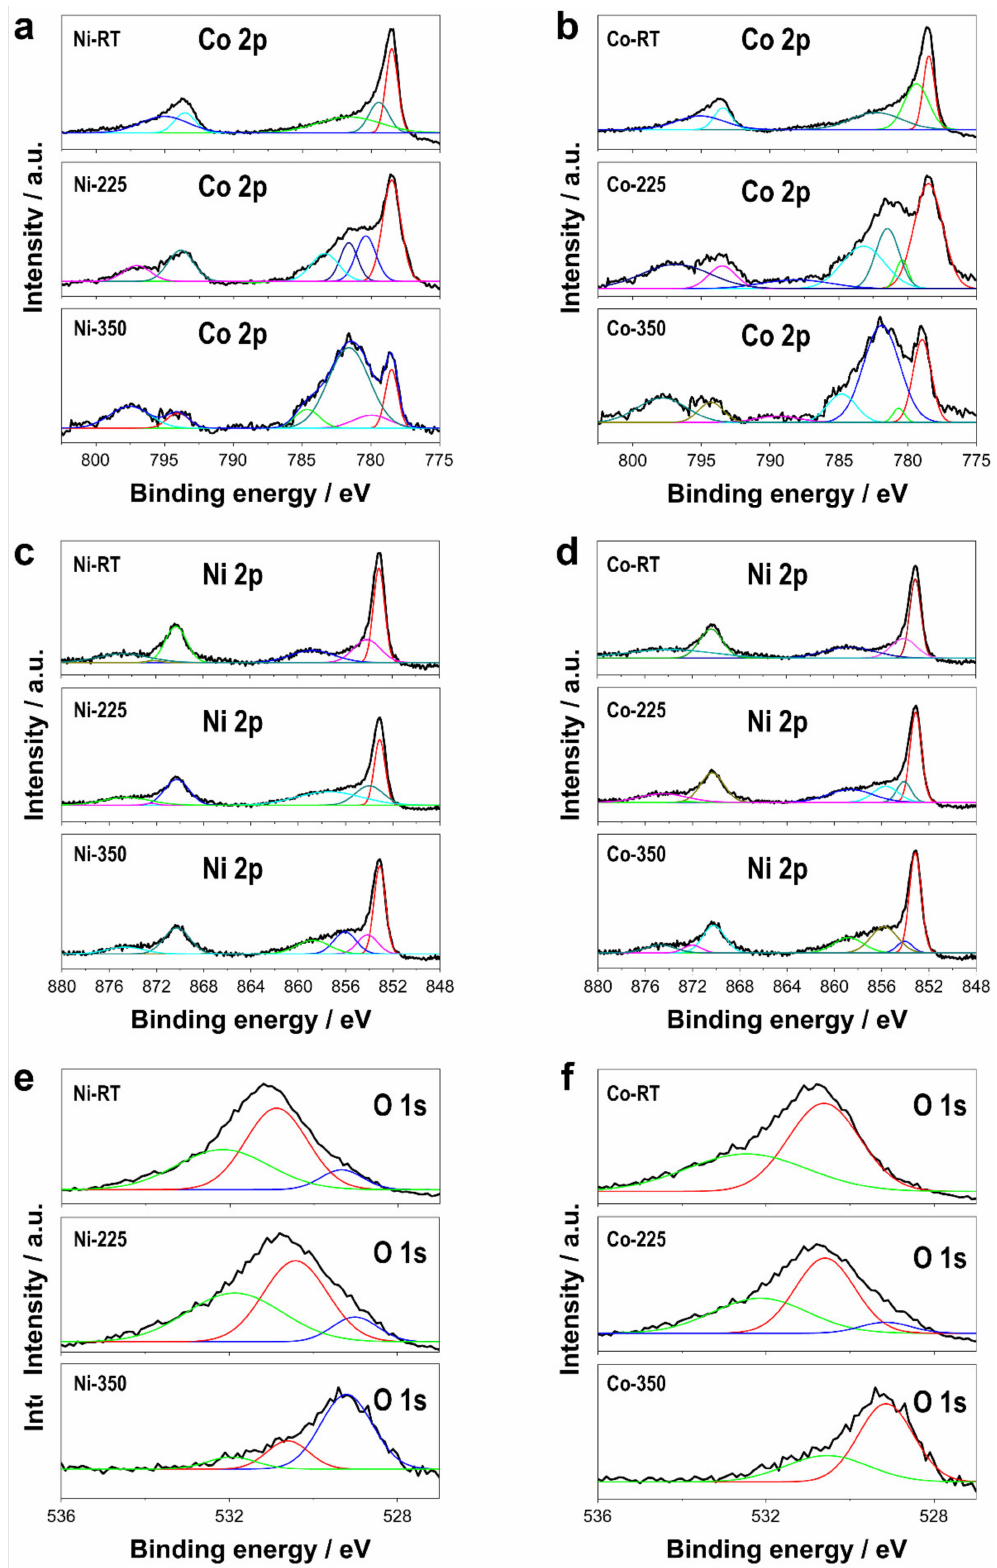
Figure 2. XPS spectra of the deposits as prepared and after thermal treatment of Co 2p of ( a ) Ni–CoNi deposits and ( b ) Co–CoNi deposits, Ni 2p of ( c ) Ni–CoNi deposits, and ( d ) Co–CoNi deposits, and O 1s of ( e ) Ni–CoNi deposits and ( f ) Co–CoNi